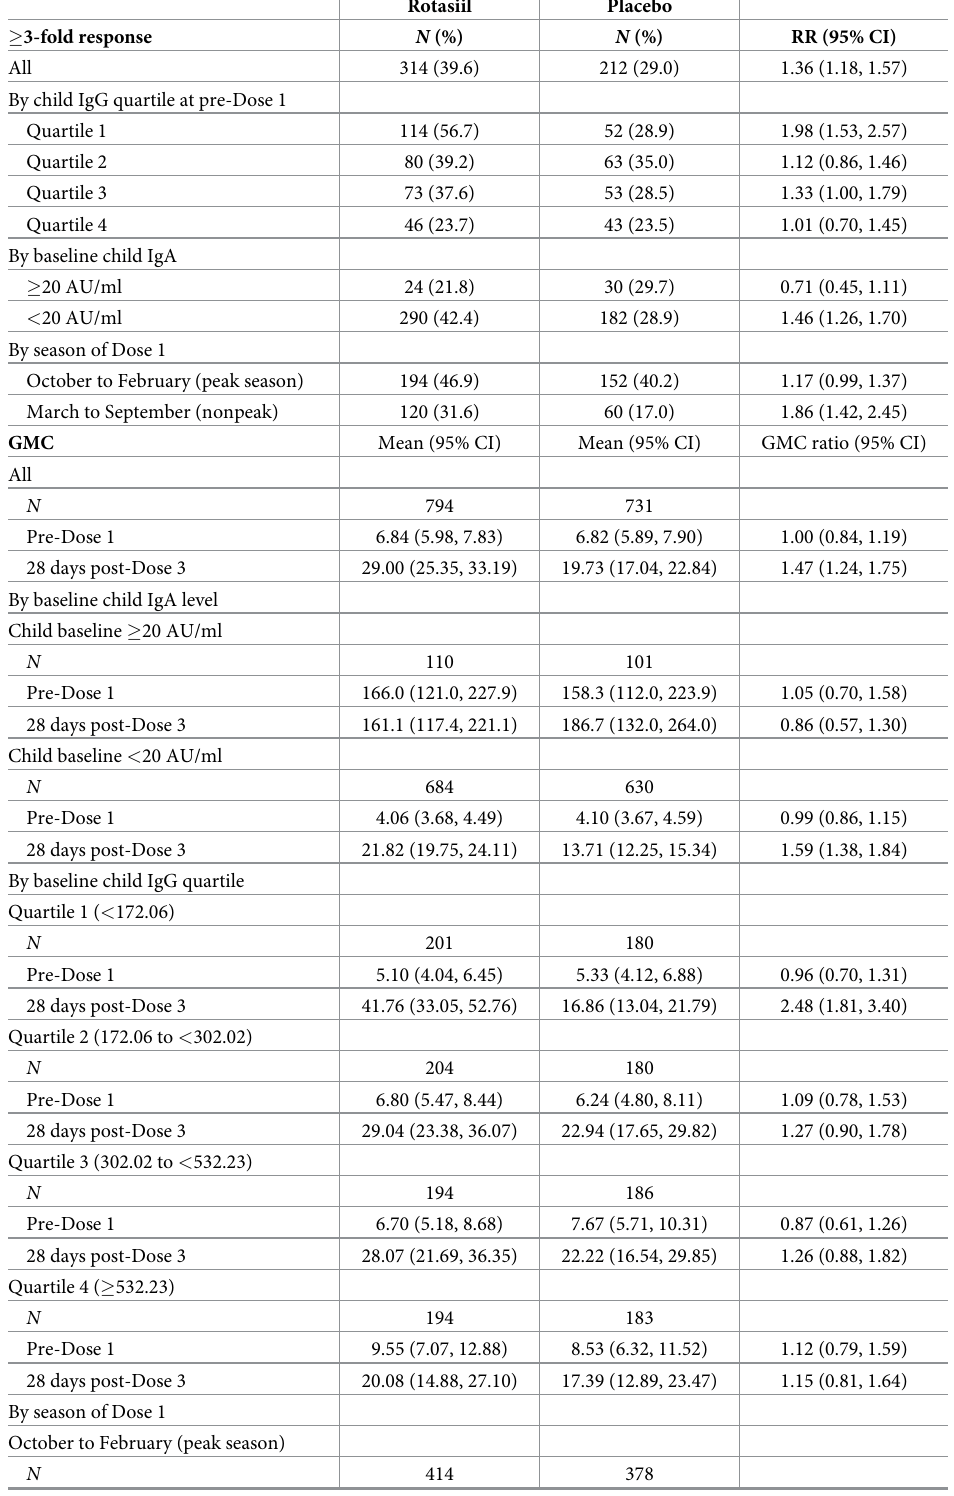
Table 3. Serum IgA seroconversion and mean concentration at Dose 1 and 28 days post-Dose